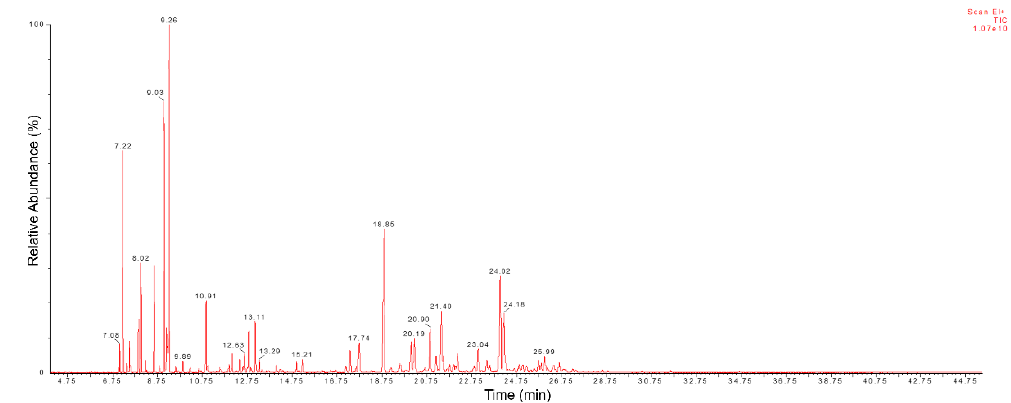
Figure 1. GC-MS total ion chromatogram of C. conduplicatus essential oil.